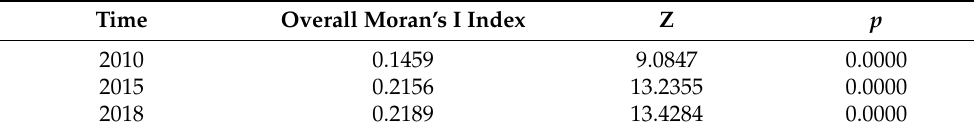
Table 6. Overall Moran’s I index of rural hollowing degree in Sichuan Province.